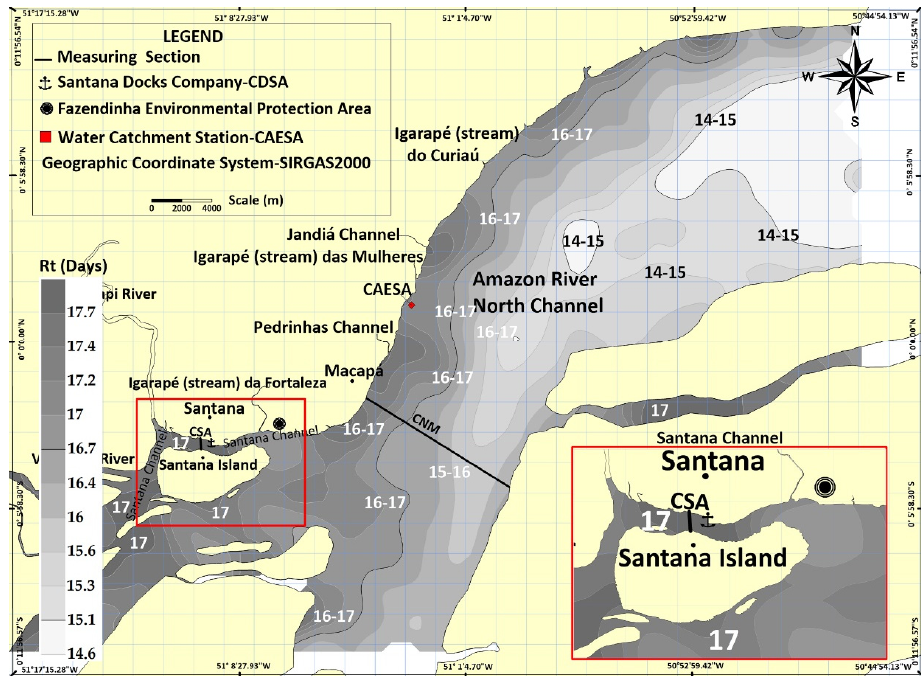
Figure 11. CNM and CSA’s water residence time (Rt) in August at time unit expressed in days. Geographic Coordinate System: Sirgas2000. Water 2019 , 11 , x FOR PEER REVIEW